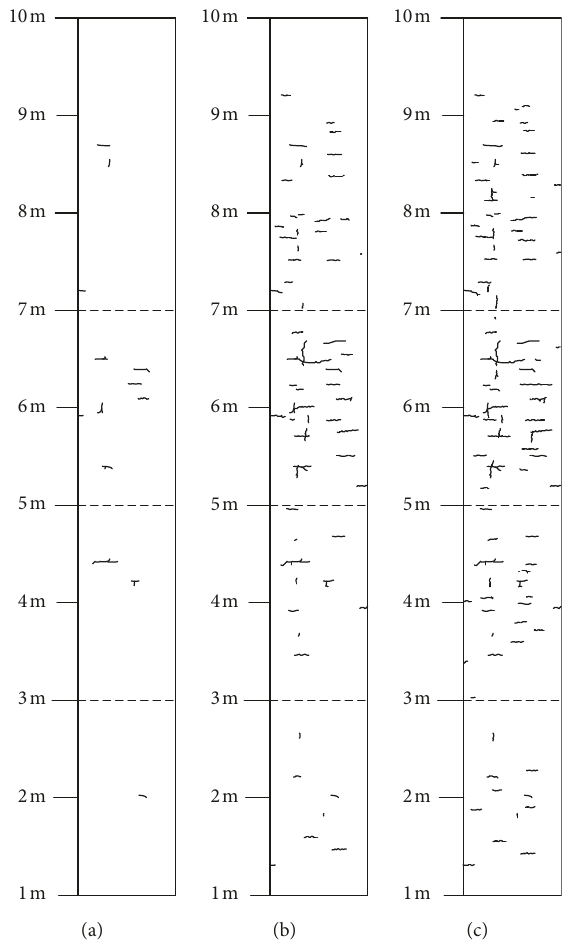
Figure 12: Results of pavement at different passes: (a) 500000 passes; (b) 600000 passes; (c) 700000 passes.